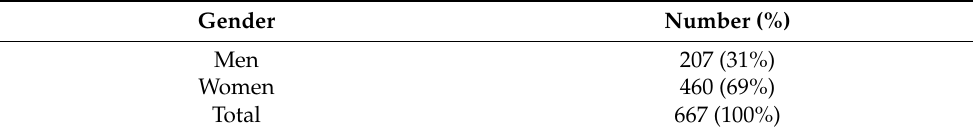
Table 2. Gender description in the editorial boards of Occupational Therapy journals. Gender